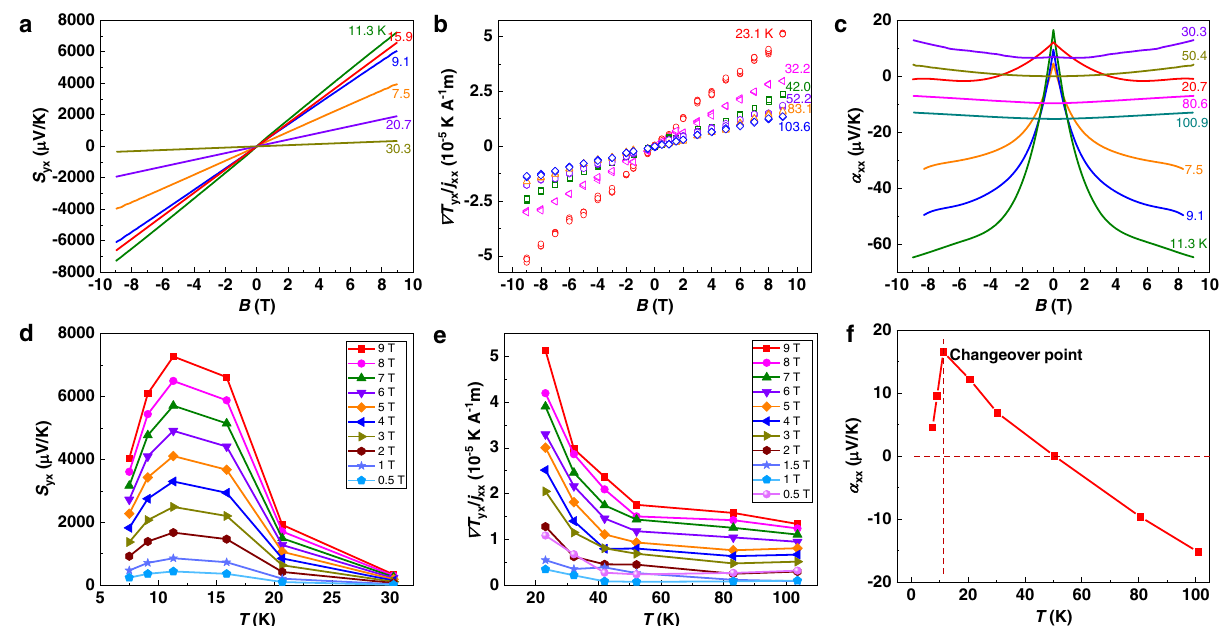
Fig. 2 Nernst, Ettingshausen, and Seebeck effect in WTe 2 . a Nernst signal from 7.5 K to 30.3 K. b Ettingshausen signal from 23.1 K to 103.6 K. c Seebeck coef fi cient from 7.5 K to 100.9 K. d Nernst signal as a function of temperature. e Ettingshausen signal as a function of temperature. f Temperature- dependent Seebeck coef fi cient at 0 T of a WTe 2 single crystal. Both the Nernst and Ettingshausen effects show large, non-saturating signals up to 9 T. The maximum Nernst effect is observed in the range of 10 – 15 K, and the maximum Ettingshausen effect observed in the present work was at 23.1 K, which is the lower temperature limit of our where ρ yx and ρ xx are the Hall and longitudinal resistivity ( ρ xx and ρ yx are shown in Fig. 3a, b), and n e and n h are the charge carrier